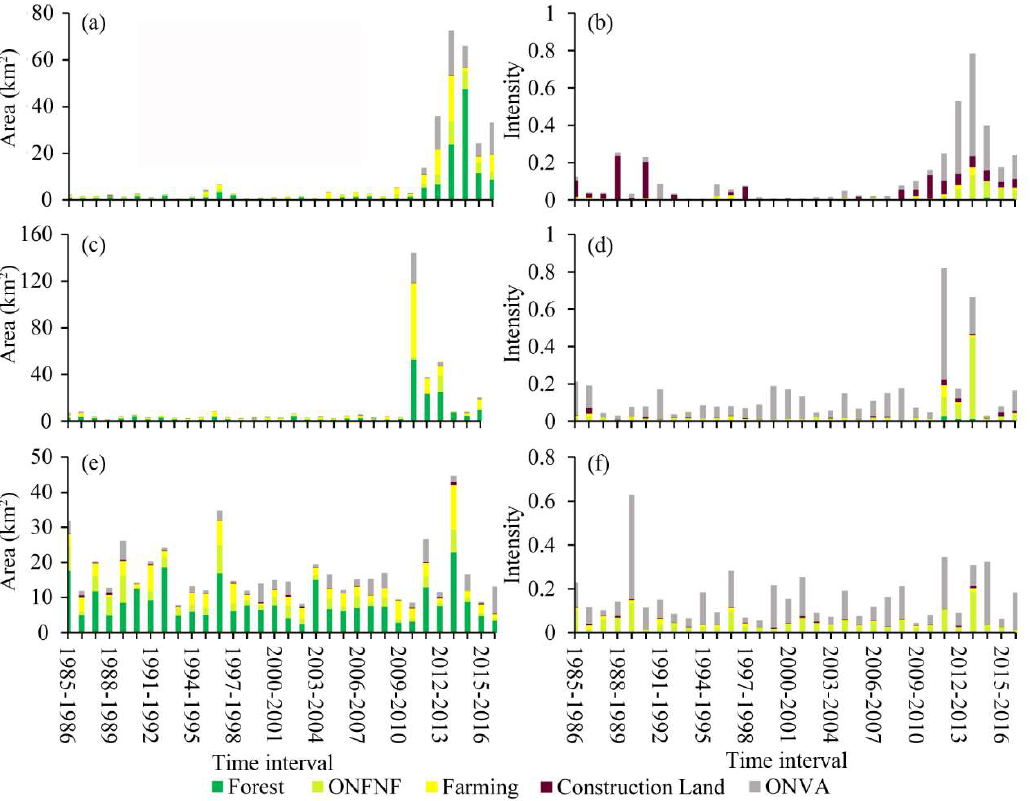
Figure 8. Water gross gain size (left panel) and intensity (right panel) in upstream ( a , b ), midstream ( c , d ), and downstream ( e , f ) regions in 1985–2017 (Note: ONFNF: other non-forest natural formation, ONVA: other non-vegetated areas).